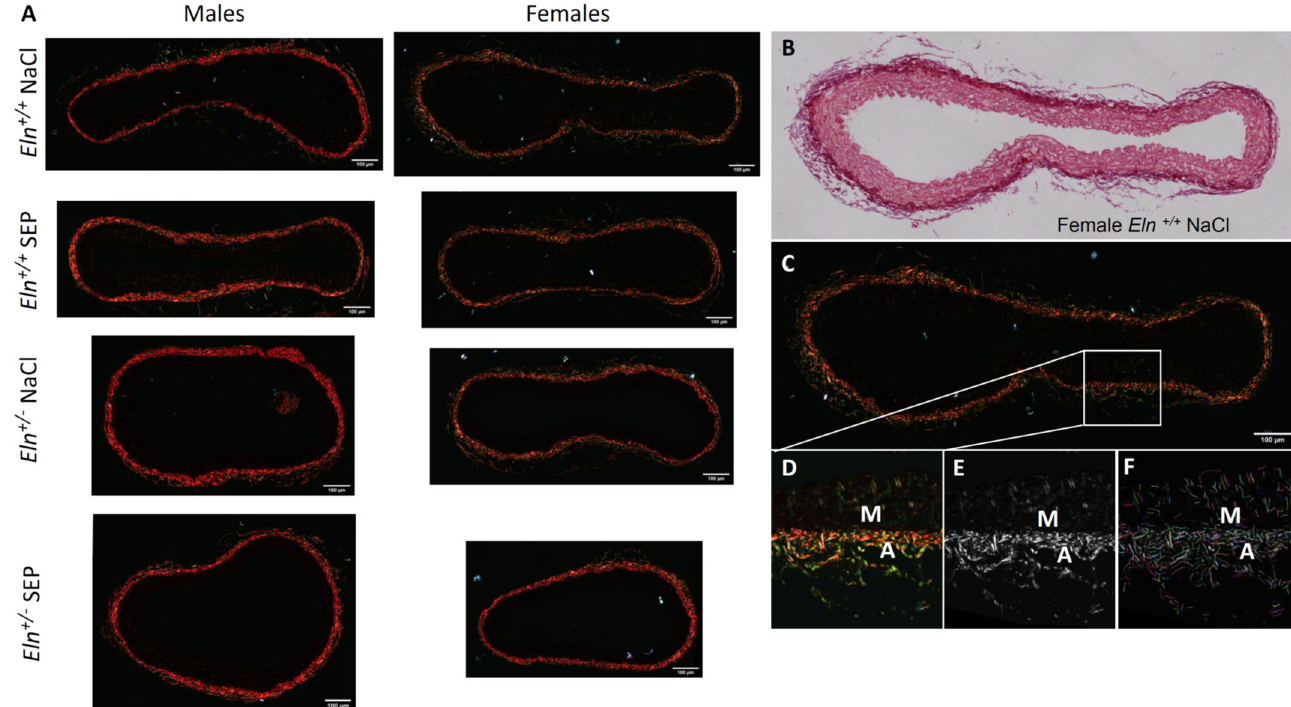
Figure 7. Images of picrosirius red ‐ stained collagen fibers in cross ‐ sections of the distal part of the aortic arch of Eln +/+ or Eln +/ ‐ male or female mice injected with SEP or 0.9% NaCl (control), illumi ‐ nated with polarized light ( A ). Representative example of an aorta from an Eln +/+ female mouse in ‐ jected with 0.9% NaCl ( B – F ), under illumination with non ‐ polarized light ( B ), compared to polar ‐ ized light ( C – F ). A magnified image of the selected area of the aorta wall shown in ( C ) is presented in ( D ). The images from the whole aorta wall were then CT ‐ FIRE ‐ processed in order to obtain the individual fiber properties and quantity of the collagen fibers in all the studied groups (fiber width, length, straightness, angle and number of fibers in the whole aorta section). The second harmonic generation (SHG) image generated from ( D ) using CT ‐ FIRE program is shown in ( E ). The extracted fibers obtained using the CT ‐ FIRE program are highlighted in different colors overlaid on the original SHG image in F. M = Media, A = Adventitia. Scale bars = 100 μ m.